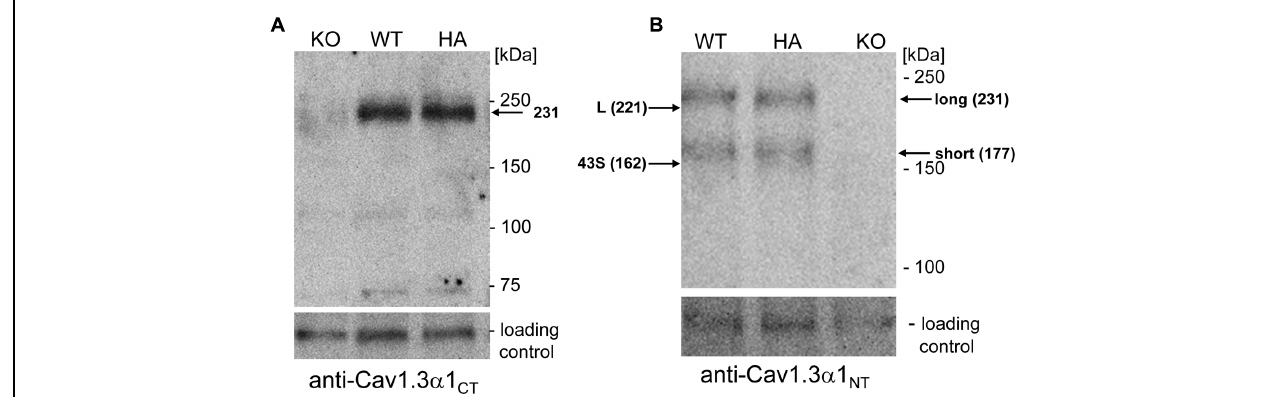
FIGURE 3 | Western blot analysis of α 1-subunits in WT and mutant migration of recombinant mCav1.3 L (L) and mCav1.343 S (43S) on the mouse brain homogenates. (A) Proteins (100 μ g/lane) were separated same gel (not shown) and their calculated molecular mass are indicated by on 5% SDS page and immunostained with polyclonal antibody Cav1.3 arrows (left). Migration of molecular mass standards as well as the brain α 1 α 1 subunit was specifically detected as a 231 kDa long and short α 1-subunit species are also indicated (right). An unspecific CT . The Cav1.3 ∼ 120 kDa band served as loading control. One representative experiment protein at expression levels indistinguishable between WT and homozygous of at least three independent experiments is shown for all panels. KO, mutants (HA) (see Results). KO, Cav1.3 − / − negative control. (B) Same separation as in A (100 μ g/lane) but detection with anti-Cav1.3 α 1 NT . The Cav1.3 − / − ; HA, Cav1.3DCRD HA / HA , WT, wild-type littermate.